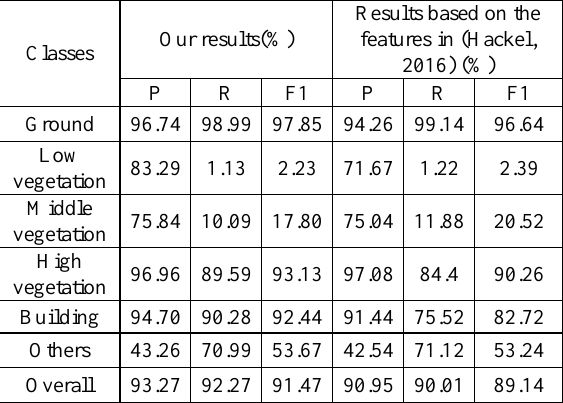
Table 3. Quantitative results of testing on airborne LiDAR point cloud (Precision (P), Recall (R), F1-Score